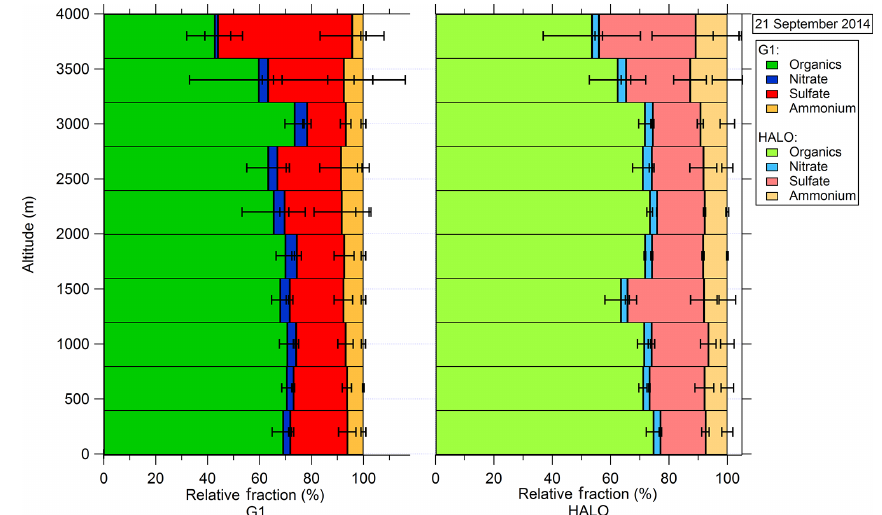
Figure 12. The vertical profile of relative mass fraction of major aerosol chemical species measured by the G1 and HALO AMS, respectively, on 21 September.